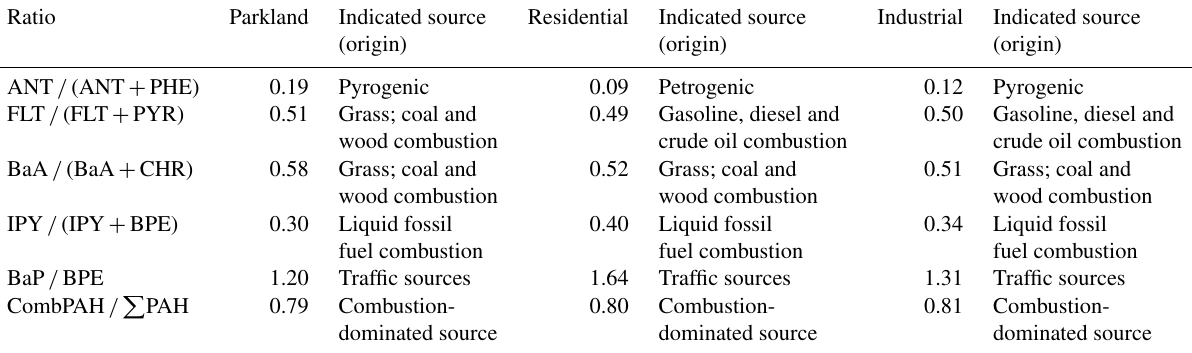
Table 5. PAH ratios in studied soils.